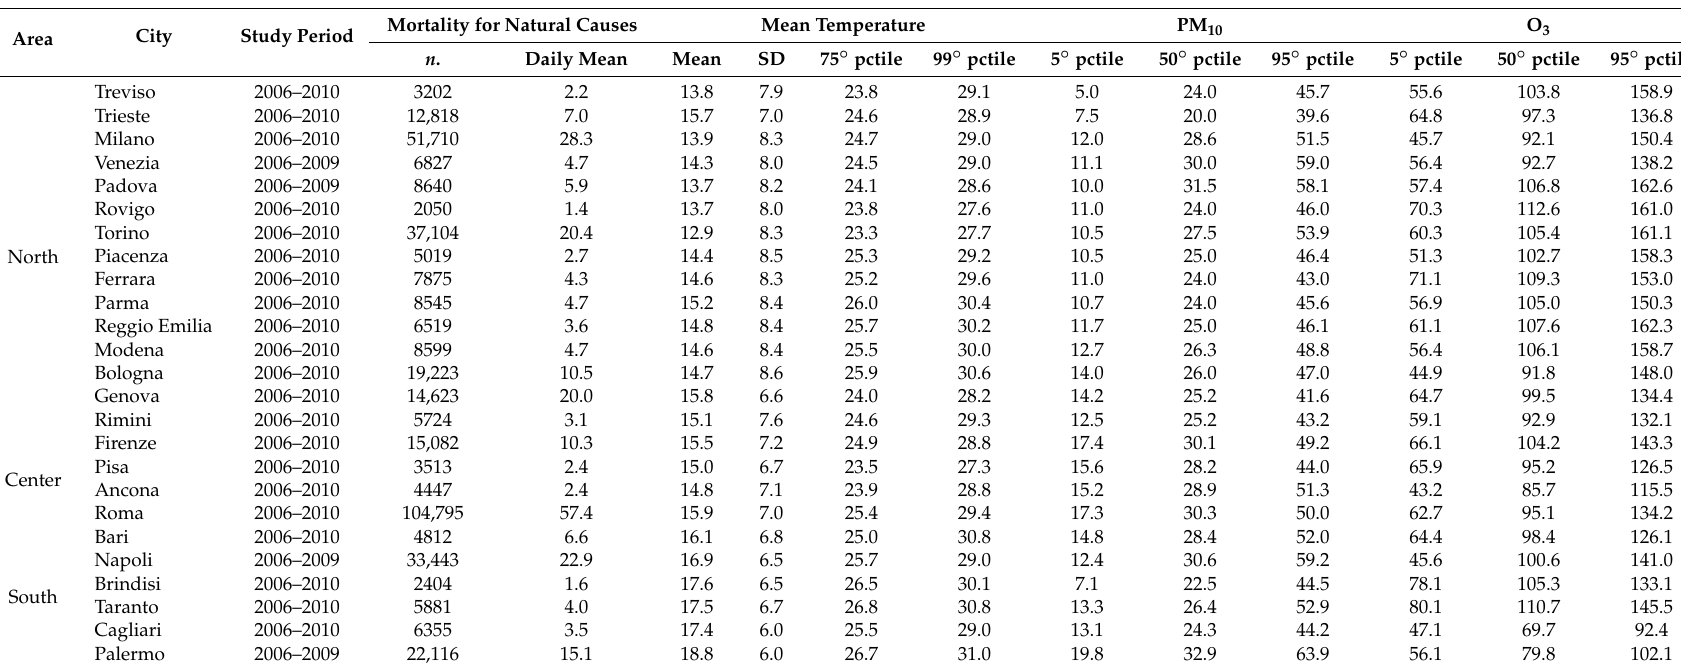
Table 1. Description of city-specific data: study period, mortality data in 35+ years population, air temperature distribution and percentiles of air pollutants used to define days with low, medium, and high PM10 and O 3